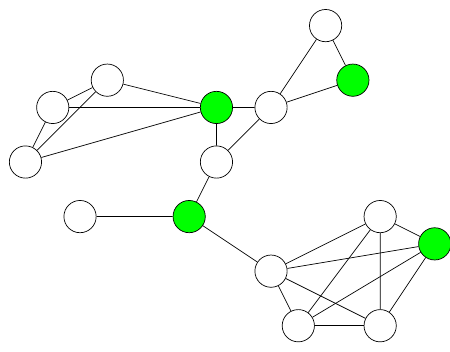
Figure 3. Maximal independent set. The nodes which form the MIS are colored in